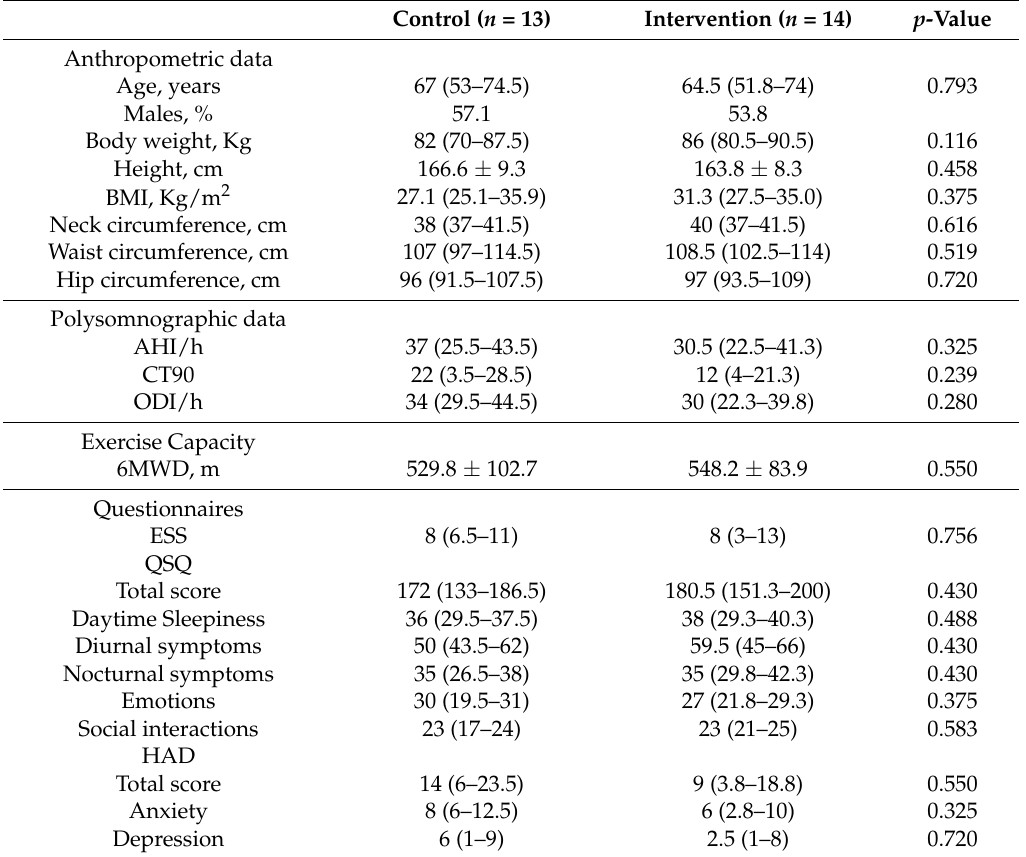
Table 1. Baseline characteristics of study participants.